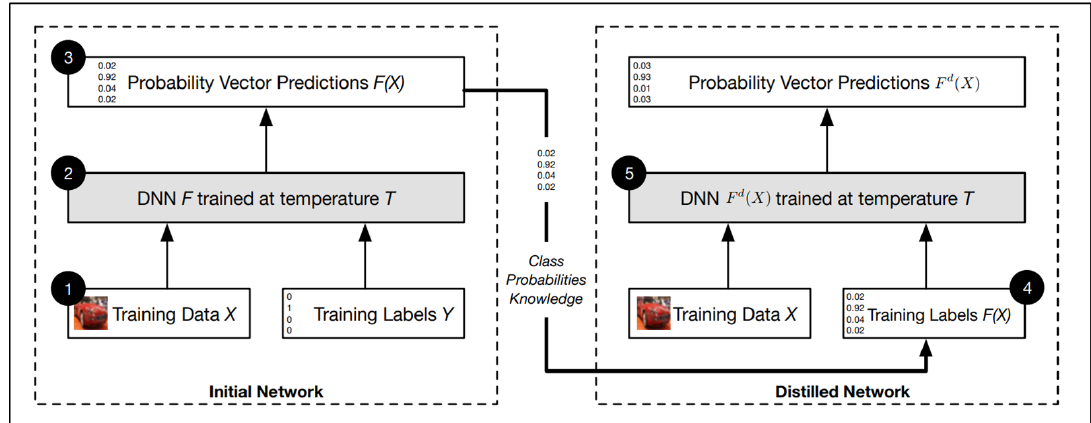
Figure 16. An overview of defense mechanism based on a transfer of knowledge contained in probability vectors through distillation (Image Credit: Papernot et al.